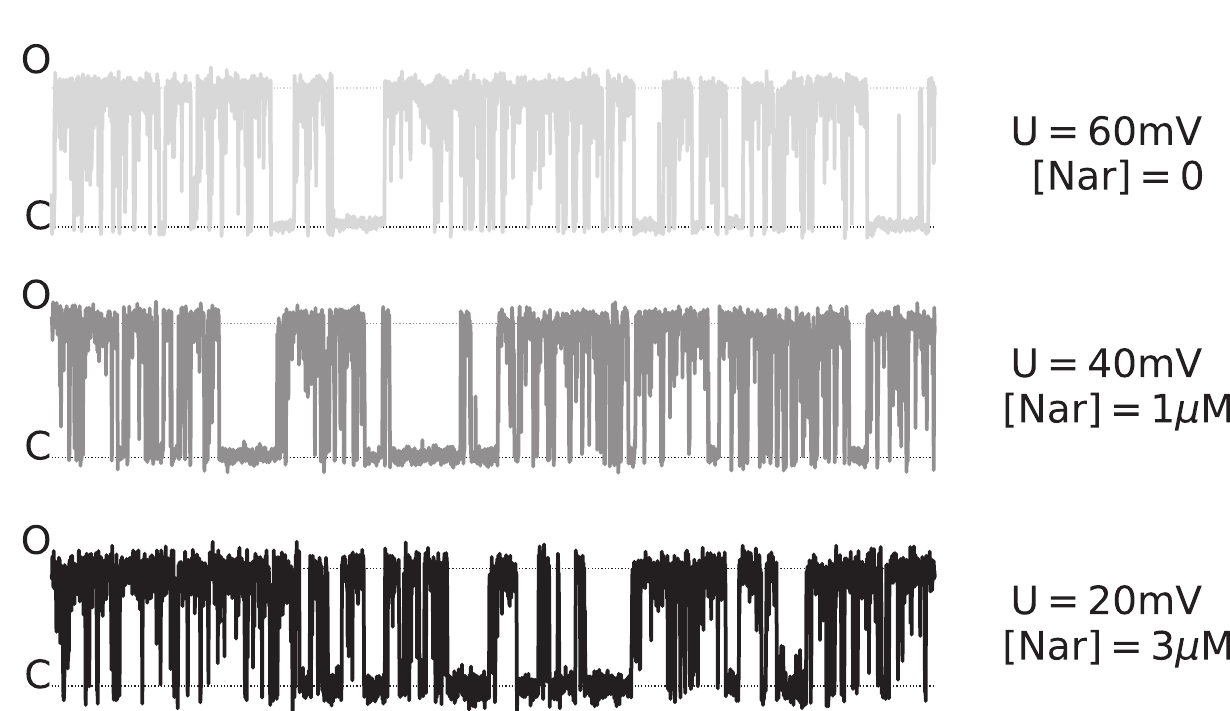
Fig 2. The representative normalized patch-clamp signals (single channel current vs. time) recorded at different membrane potentials U naringenin concentrations [Nar]. The presented traces correspond to the first group of recordings used for ML classification. As one can see, the compared traces have a similar overall characteristics.